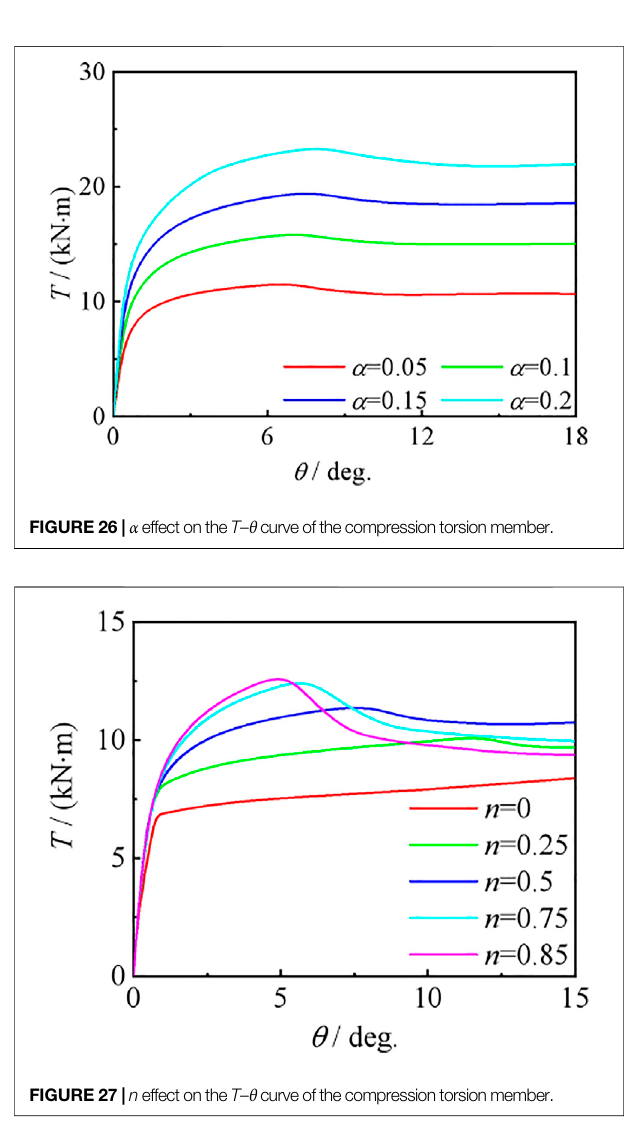
FIGURE 28 | Typical N ct / N u - T ct / T u curve of